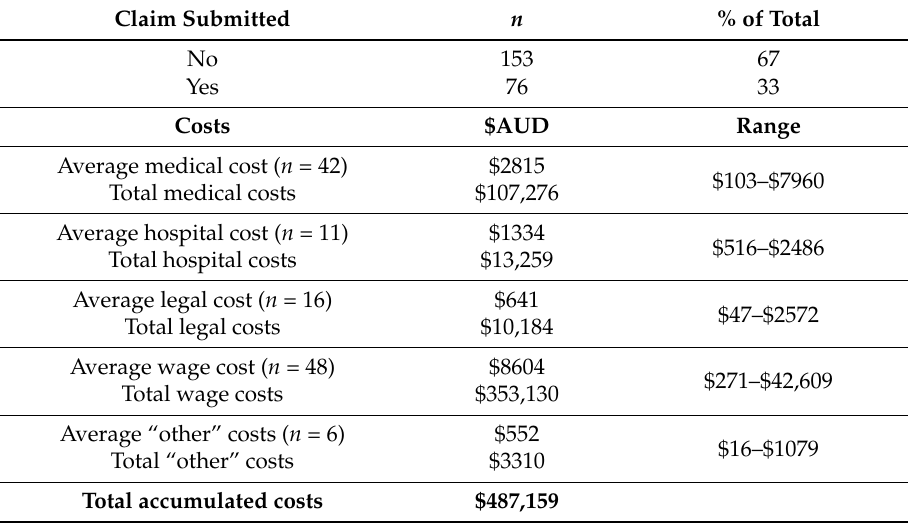
Table 3. Injury claims submitted and associated financial costs during the four-year